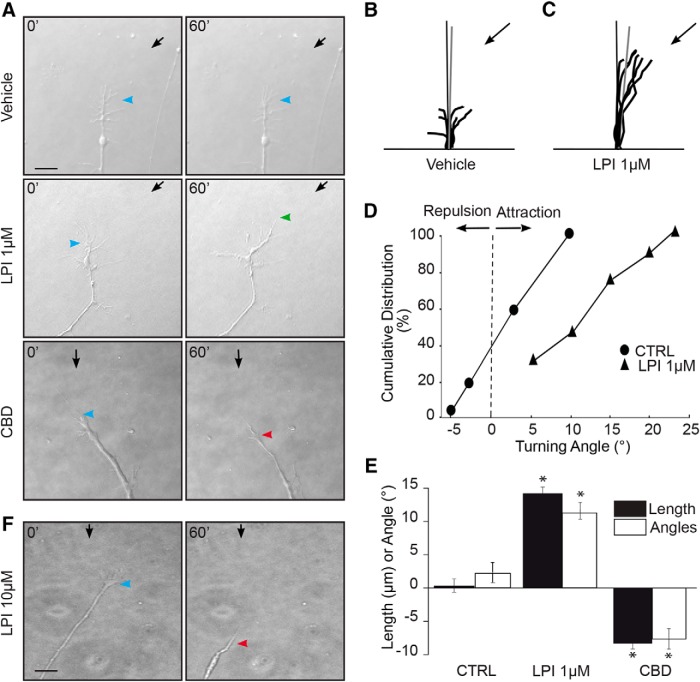
Pharmacological modulation of GPR55 affects RGC turning in vitro. A, Photomicrographs of time-lapse microscopy from 1 DIV mouse retinal explant growth cone taken at t = 0 min and t = 60 min during GC turning assay experiments. Black arrows indicate the direction of the microgradient, whereas blue arrowheads indicate initial GC position. Green arrowheads show the GC position following neurite attraction and red arrowheads indicate the GC position after repulsion. B, C, Superimposed RGC axon trajectories over the 60 min observation period for vehicle and LPI; no significant changes were observed on growth cone behavior in the presence of the vehicle, whereas LPI increased axon growth and turning toward the pipette tip. Black arrows indicate the direction of the gradient. D, Turning angle cumulative frequency curves of RGC growth cones. The turning angle of each growth cone was plotted against the percentage of growth cones turning that angle or less. E, Quantification of neurite elongation and GC turning responses following drug stimulation. F, Representative photomicrograph of the effect of repulsion and GC collapse created during 60 min stimulation with 10 µm LPI. Scale bars: A, F, 40 μm. Values are presented as means ± SEM; *indicates significant change compared with the vehicle in E; p < 0.0001.